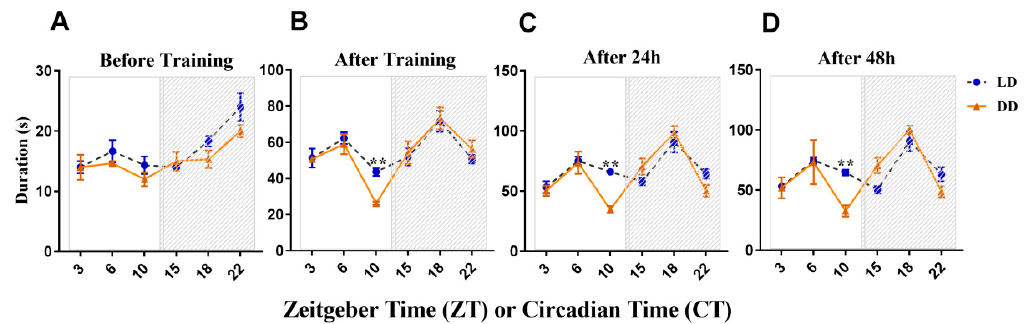
Figure 3. The rhythms of mantle-upturned reflex duration are shown for Onchidium examined in constant darkness (DD) (blue circles) and light–dark cycle (LD) (orange triangle) conditions. ( A ) The duration of the baseline mantle-upturned reflex before long-term memory (LTM) training shows an increased tendency of duration in the night-time. Moreover, no significant di ff erences were observed in the duration of the mantle-upturned reflex between ZT and CT, and there was no significant e ff ect of lighting condition × sampling time ( p = 0.264). ( B ) Rhythm in the acquisition. Peak durations observed at CT / ZT 6 and CT / ZT 18. The duration in the “after training” stage revealed a significant e ff ect of lighting condition (lighting condition, p < 0.05), as well as a significant e ff ect of sampling time (time, p < 0.01). Bonferroni post hoc tests revealed that the durations between ZT 10 and CT 10 were significantly di ff erent (** p < 0.01). ( C ) A subset of animals was tested after 24 h to determine whether the rhythm in LTM persisted under LD / DD (lighting condition, p < 0.05; time, p < 0.001). The durations between ZT 10 and CT 10 also exhibited significant di ff erences (** p < 0.01). ( D ) Animals were tested after 48 h to determine whether the rhythm in LTM persisted under LD / DD. There was no significant e ff ect of lighting condition × sampling time (two-way analysis of variance (ANOVA), p > 0.05), whereas the duration at ZT 10 and CT 10 showed significant di ff erences (** p < 0.01). Statistical analyses of all data were performed using two-way ANOVA with Bonferroni post hoc analysis for comparisons between groups. Values are means ± SEM (standard error of the mean) ( n = 6 for ZT 3, 6, 10, 15, 18, and 22 and CT 3, 6, 10, 15, 18, and 22).